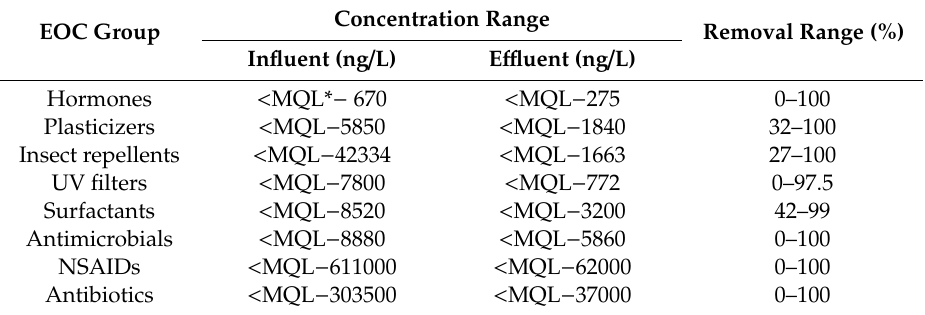
Table 1. Concentrations of compounds from the main groups of emerging organic contaminants (EOCs) recorded in urban wastewater and the e ffi ciency of their removal in conventional wastewater treatment plants (WWTP) (based on ref [5–11]). Concentration Range EOC Group Removal Range (%) Influent (ng / L) E ffl uent (ng / L)